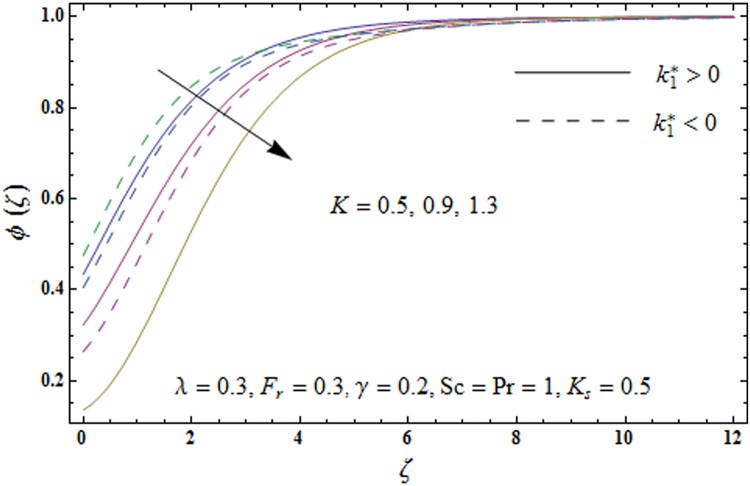
Plots of concentration field ϕ(ζ) for strength of homogeneous reaction Ks.